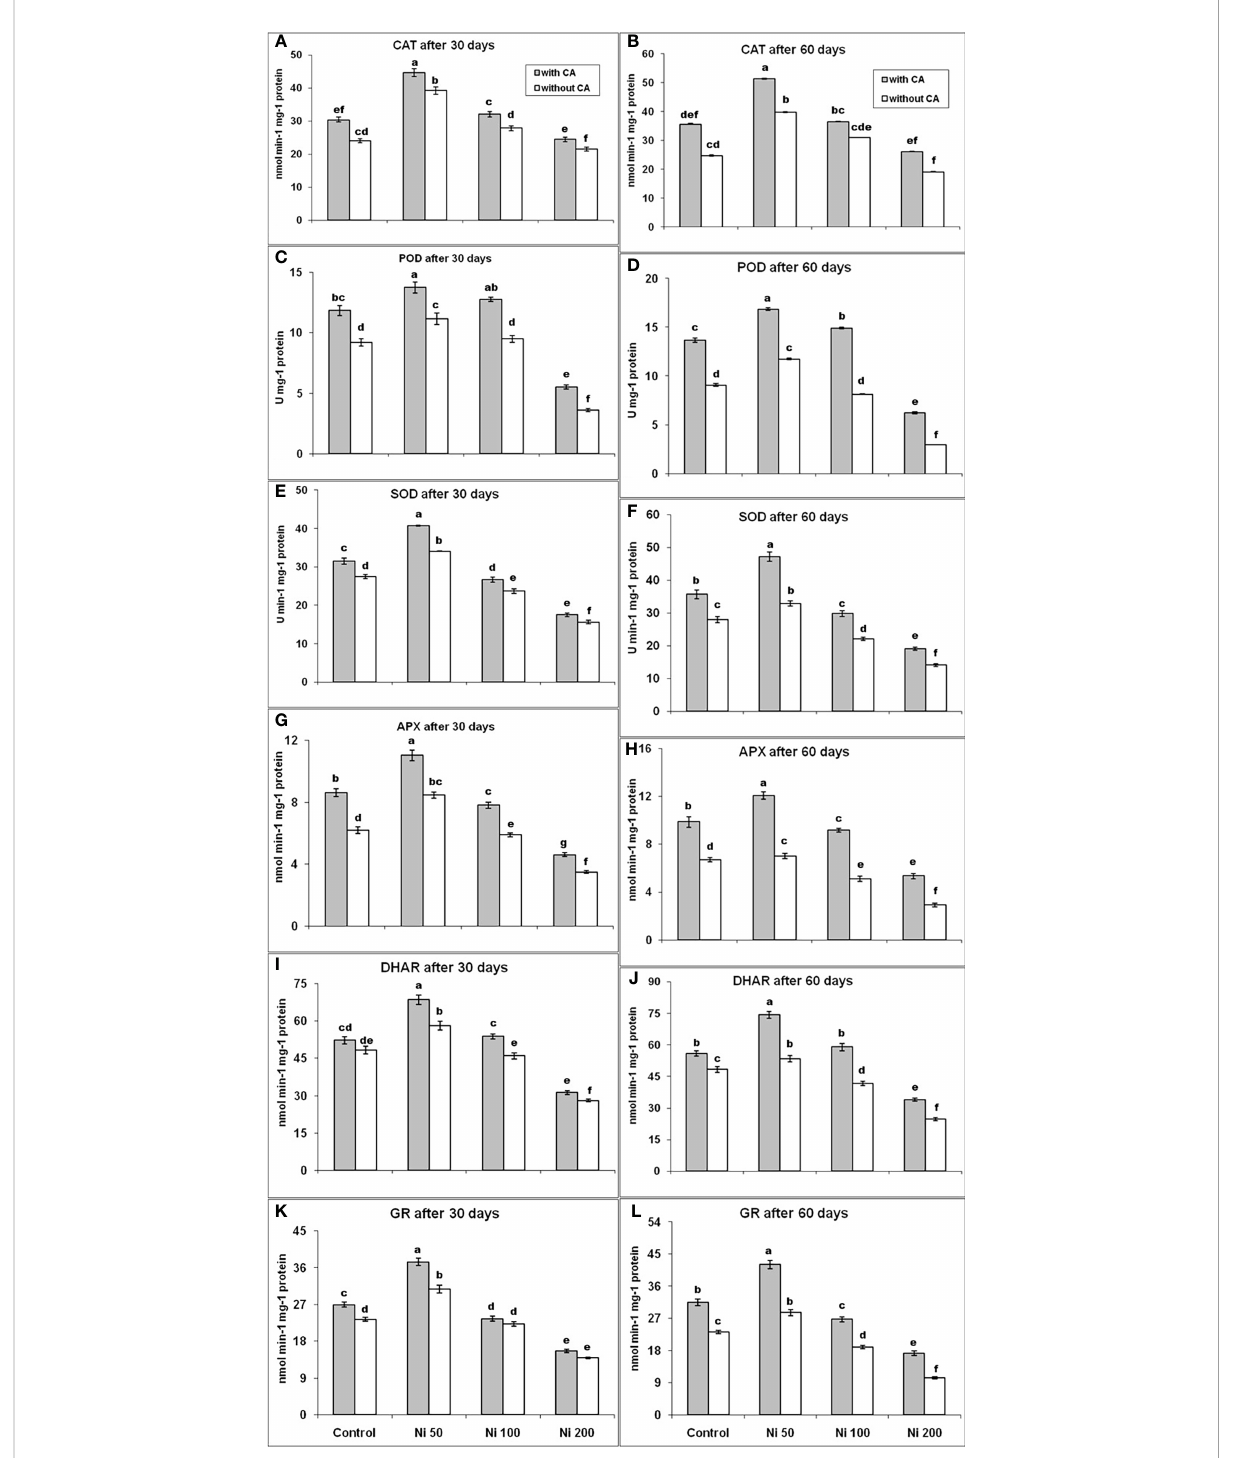
FIGURE 4 CAT after 30 days (A) , CAT after 60 days (B) , POD after 30 days (C) , POD after 60 days (D) , SOD after 30 days (E) , SOD after 60 days (F) , APX after 30 days (G) , APX after 60 days (H) , DHAR after 30 days (I) , DHAR after 60 days (J) , GR after 30 days (K) and GR after 60 days (L) , in sun fl ower plants. The bars designated with Ni 50, Ni 100, and Ni 200 represent Ni concentration at 50, 100, and 200ppm, respectively. “ With CA ” means these Ni-stressed plants are supplemented with 5 mM CA and vice versa for “ Without CA ” . The bars denoted by different letters are signi fi cantly variable at P ≤ 0.05 using the LSD